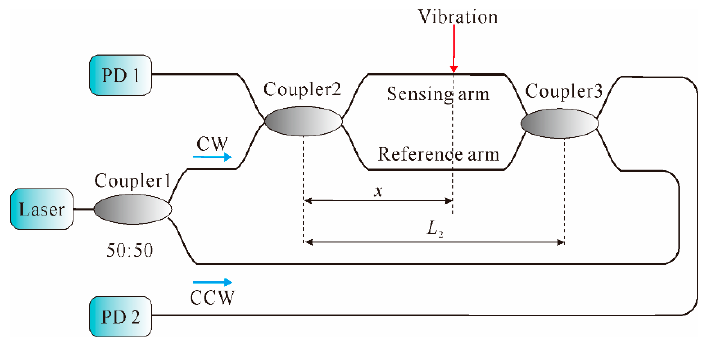
Figure 3. Schematic diagram of DMZI vibration sensors.